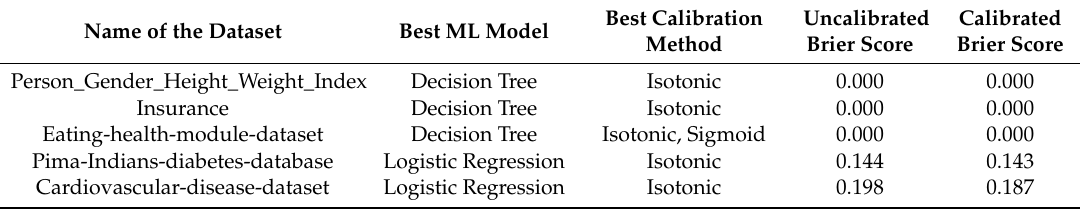
Table 12. The data processing synopsis with the calibrated